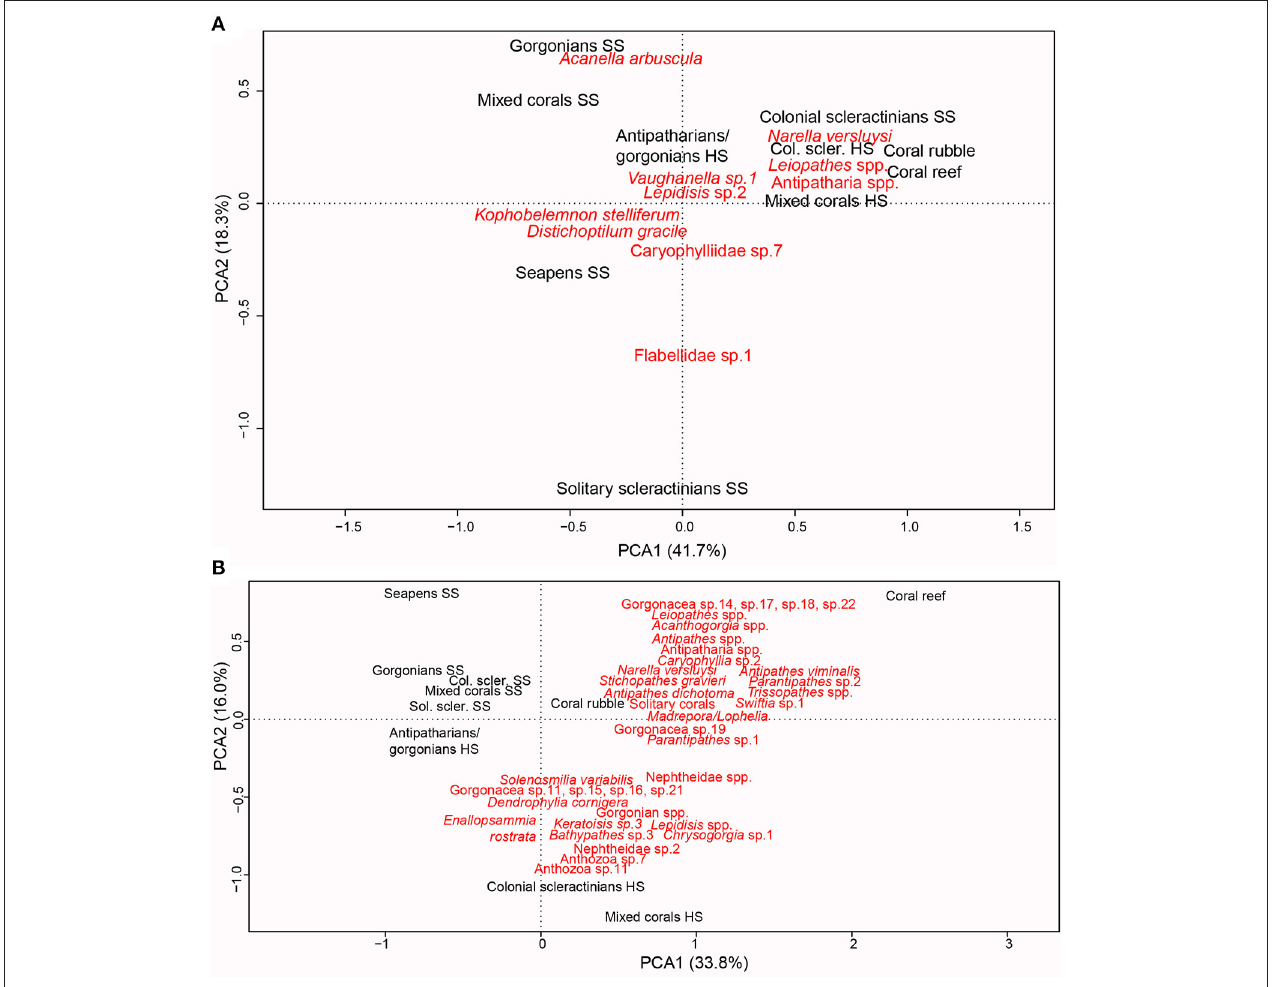
FIGURE 4 | Biplot ordination of the coral habitats (in black) and coral taxa (in red) in the two first axis of (A) a covariance PCA computed on Hellinger-transformed abundances of non-reef forming coral taxa per habitat. For clarity only those species contributing to at least 5% of the variance along one axis are represented. (B) A correlation PCA computed on raw abundances of non-reef forming corals or percent cover of reef-forming corals ( M. oculata , L. pertusa, and S. variabilis ). For clarity, only those species contributing for at least 3% of the variance along one axis are represented. Col. scler. HS, Colonial scleractinians HS; Col. scler. SS, Colonial scleractinians SS; Sol. scler. SS, Solitary scleractinians